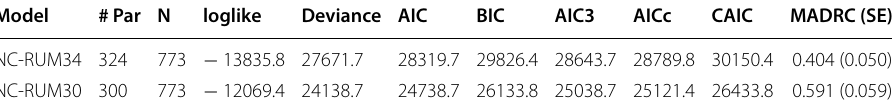
Table 3 Relative model fit